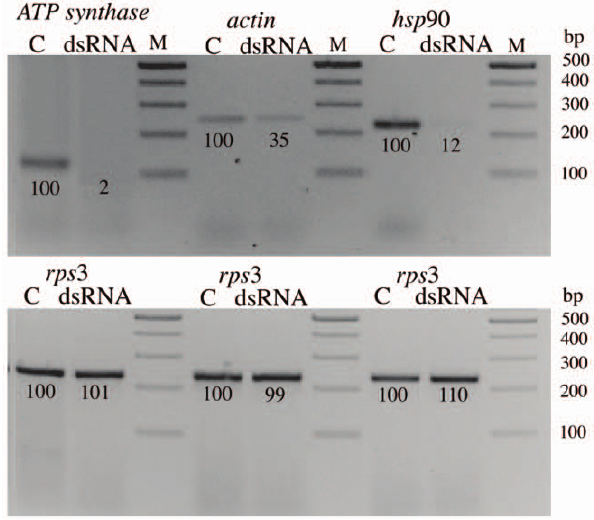
Figure 4. Silencing of actin, hsp90 and ATP synthase by RNAi in Aedesaegypti larvae. The expression of these proteins was silenced by feeding dsRNA to A. aegypti larvae. The expression of each gene was analyzed by RT-PCR assays. Numbers under the bands are percentage in relation to the control band, after densitometry analysis using ImageJ program. The control bands correspond to non-silenced larvae, which were labeled with a C and were considered as 100%. M, molecular size marker in